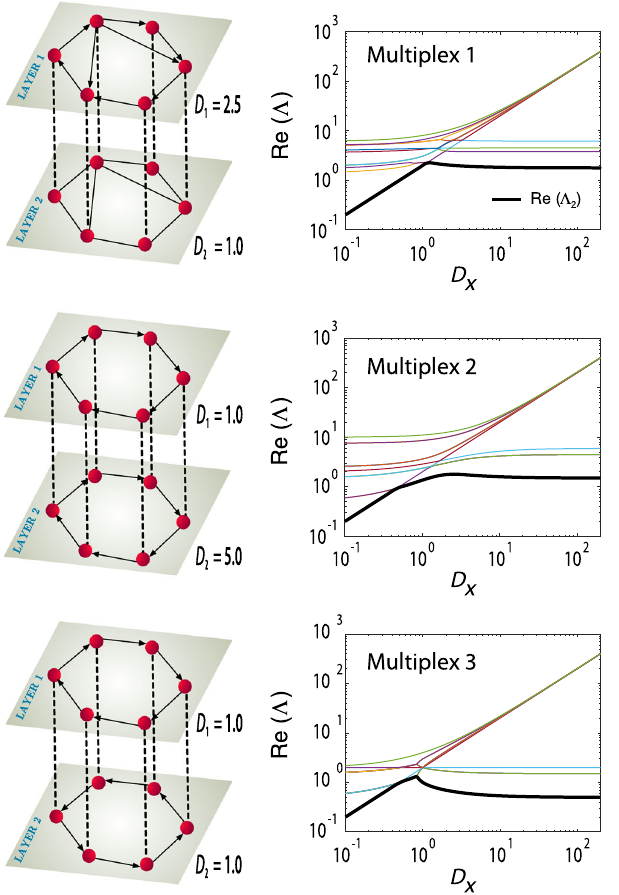
FIG. 11. Mathematical nature of the optimal coupling maxima.